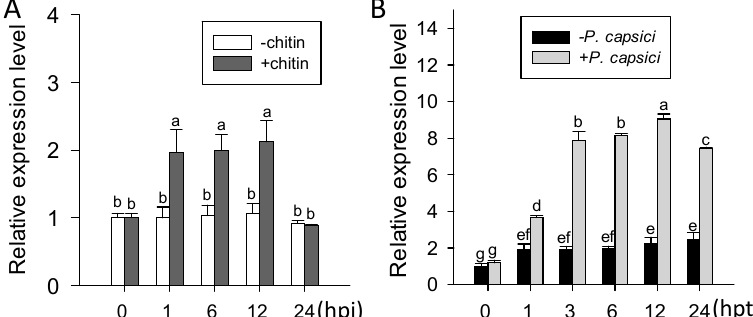
Figure 1. Transcript levels of ChiIV3 in pepper plant in response to exogenously applied chitin treatment and Phytophthora capsici inoculation. ( A ) The relative transcript levels of ChiIV3 detected in the pepper leaves inoculated with 10 µ L P. capsici zoospores (OD 595 = 0.6) at different time-points. Hpi, hours post inoculation; ( B ) The transcript level of ChiIV3 can be significantly induced in pepper leaves treated with applied chitin. Hpt, hours post treatment. ( A , B ) The expression level of untreated plants was set to “1”. Values are means ± SD ( n = 3). Different letters indicate significant differences determined by Fisher’s protected least significant difference (LSD) test ( p < 0.05).